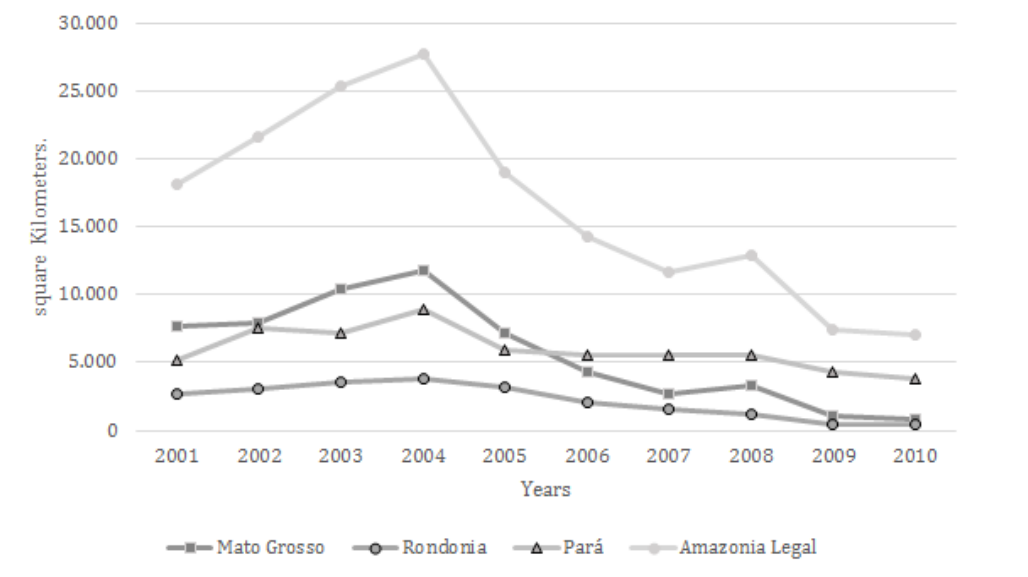
Figure 1: Deforestation and the effects of government policies in the Brazilian Amazon